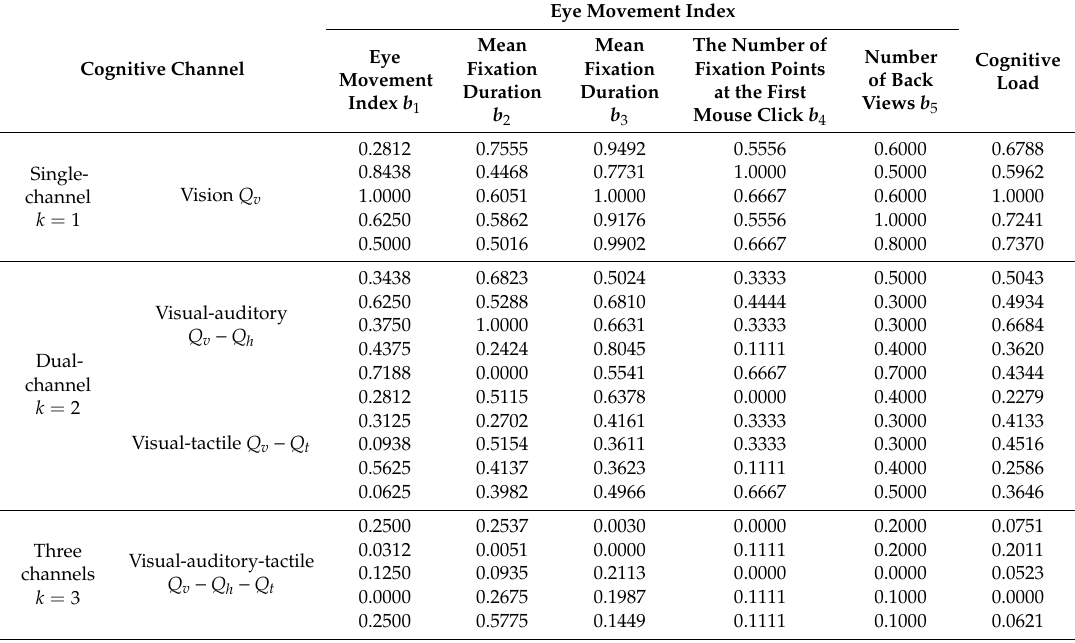
Table 7. Normalized eye movement index data.